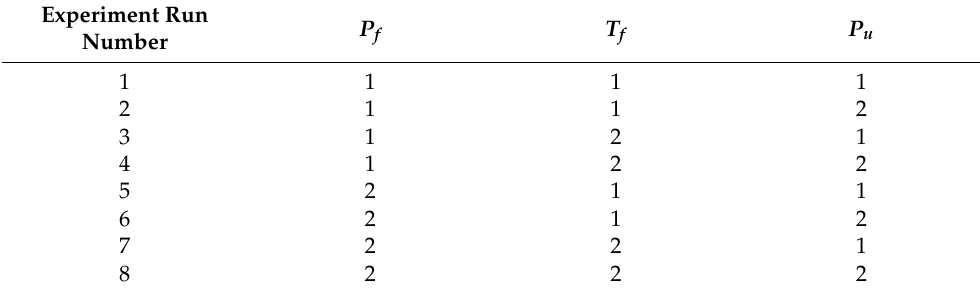
Table 4. Taguchi L 8 orthogonal array. Experiment Run